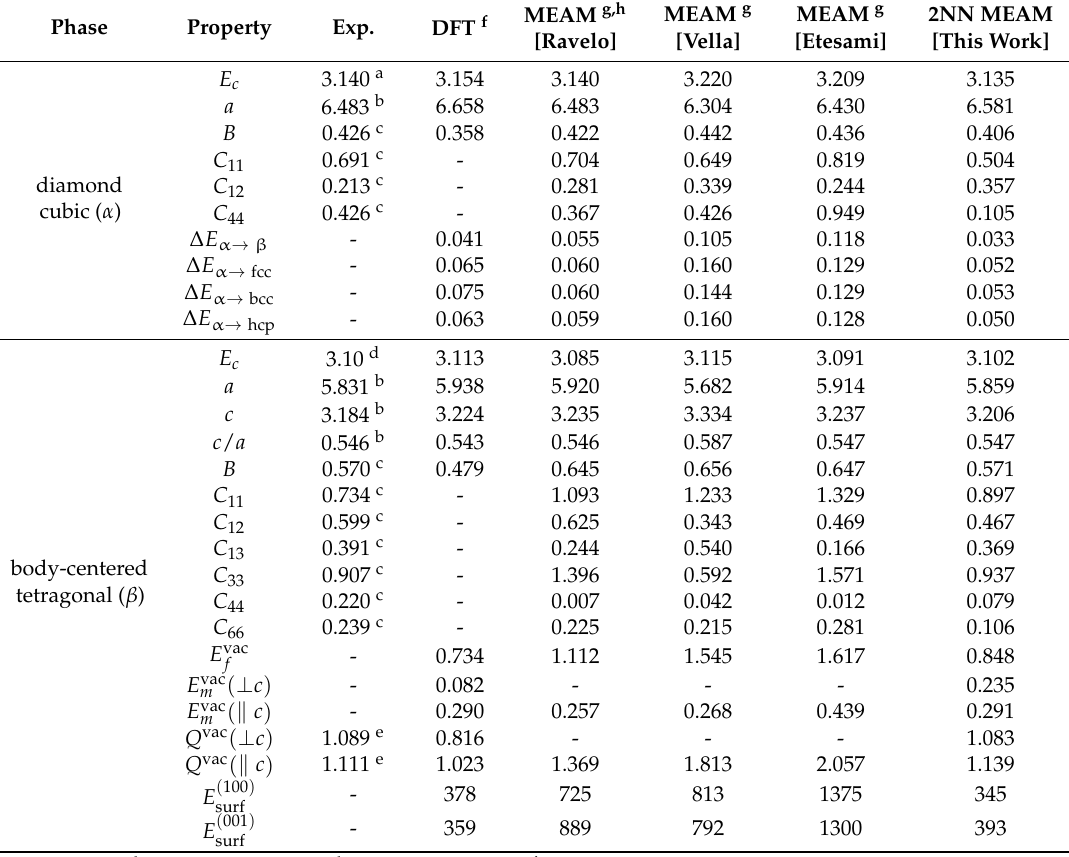
Table 3. Calculated bulk, elastic and defect properties of pure Sn using the present 2NN MEAM potential, in comparison with experimental data, DFT data, and the calculation results using previous MEAM potentials by Ravelo and Baskes [5], Vella et al. [12], and Etesami et al. [13]. The following quantities are listed: the cohesive energy E c (eV/atom), the lattice constant a (Å), the bulk modulus B and the elastic constants C 11 , C 12 , C 13 , C 33 , C 44 and C 66 (10 12 dyne/cm 2 ), the structural energy differences ∆ E (eV/atom), the vacancy formation energy E vac (eV), the vacancy migration energy E vac m f (eV), the activation energy of vacancy diffusion Q vac (eV), and the surface energies E surf (erg/cm 2 ) for the orientations indicated by the superscript. For the E vac m and Q vac , values considering diffusional paths along the a - or b -direction ( ⊥ c ) and along the c -direction ( (cid:107) c ) of the β phase are presented. The DFT and MEAM calculations were performed at 0 K while the experimental data were obtained at finite